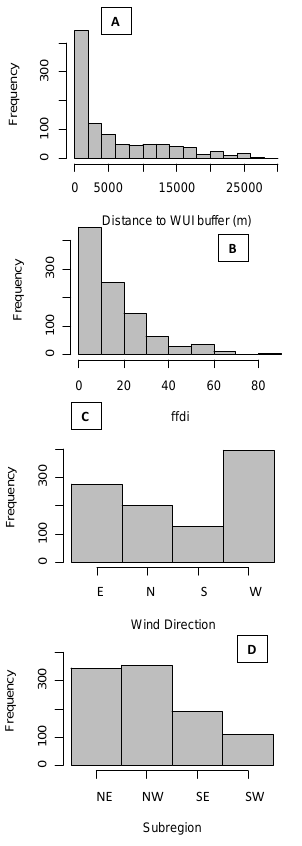
Fig. 2. Frequency histograms for the predictor variables: (A) dis- tance to WUI buffer; (B) FFDI; (C) wind direction; (D) subregion. 1880 m for SE and 8120 m for SW). When distance and weather were controlled for, this region was at relatively low risk (Table 2).